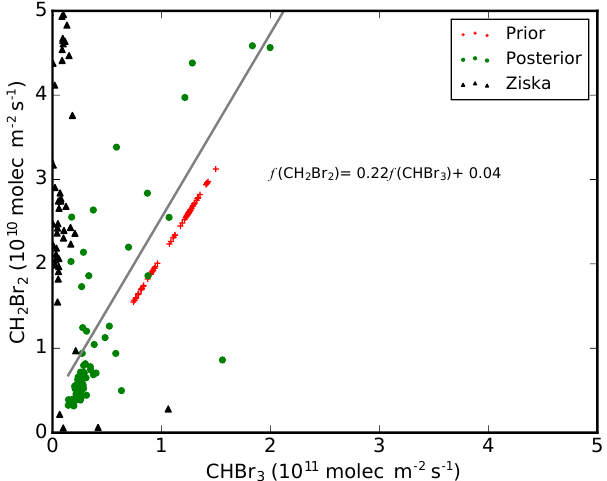
Figure 5. Scatterplot between CHBr 3 and CH 2 Br 2 fluxes described on 2 ◦ (latitude) × 2.5 ◦ (longitude) grid boxes over the main study region (130–155 ◦ E and 0–12 ◦ N, Fig. 1). Red crosses denote values from Ordóñez et al. (2012), which we use for our a priori; black tri- angles denote values from an alternative bottom-up inventory (Ziska et al., 2013); and green circles denote our a posteriori values. A pos- teriori fluxes of CHBr 3 and CH 2 Br 2 have a Pearson correlation of 0.86, and the best-fit linear model for the a posteriori fluxes is shown